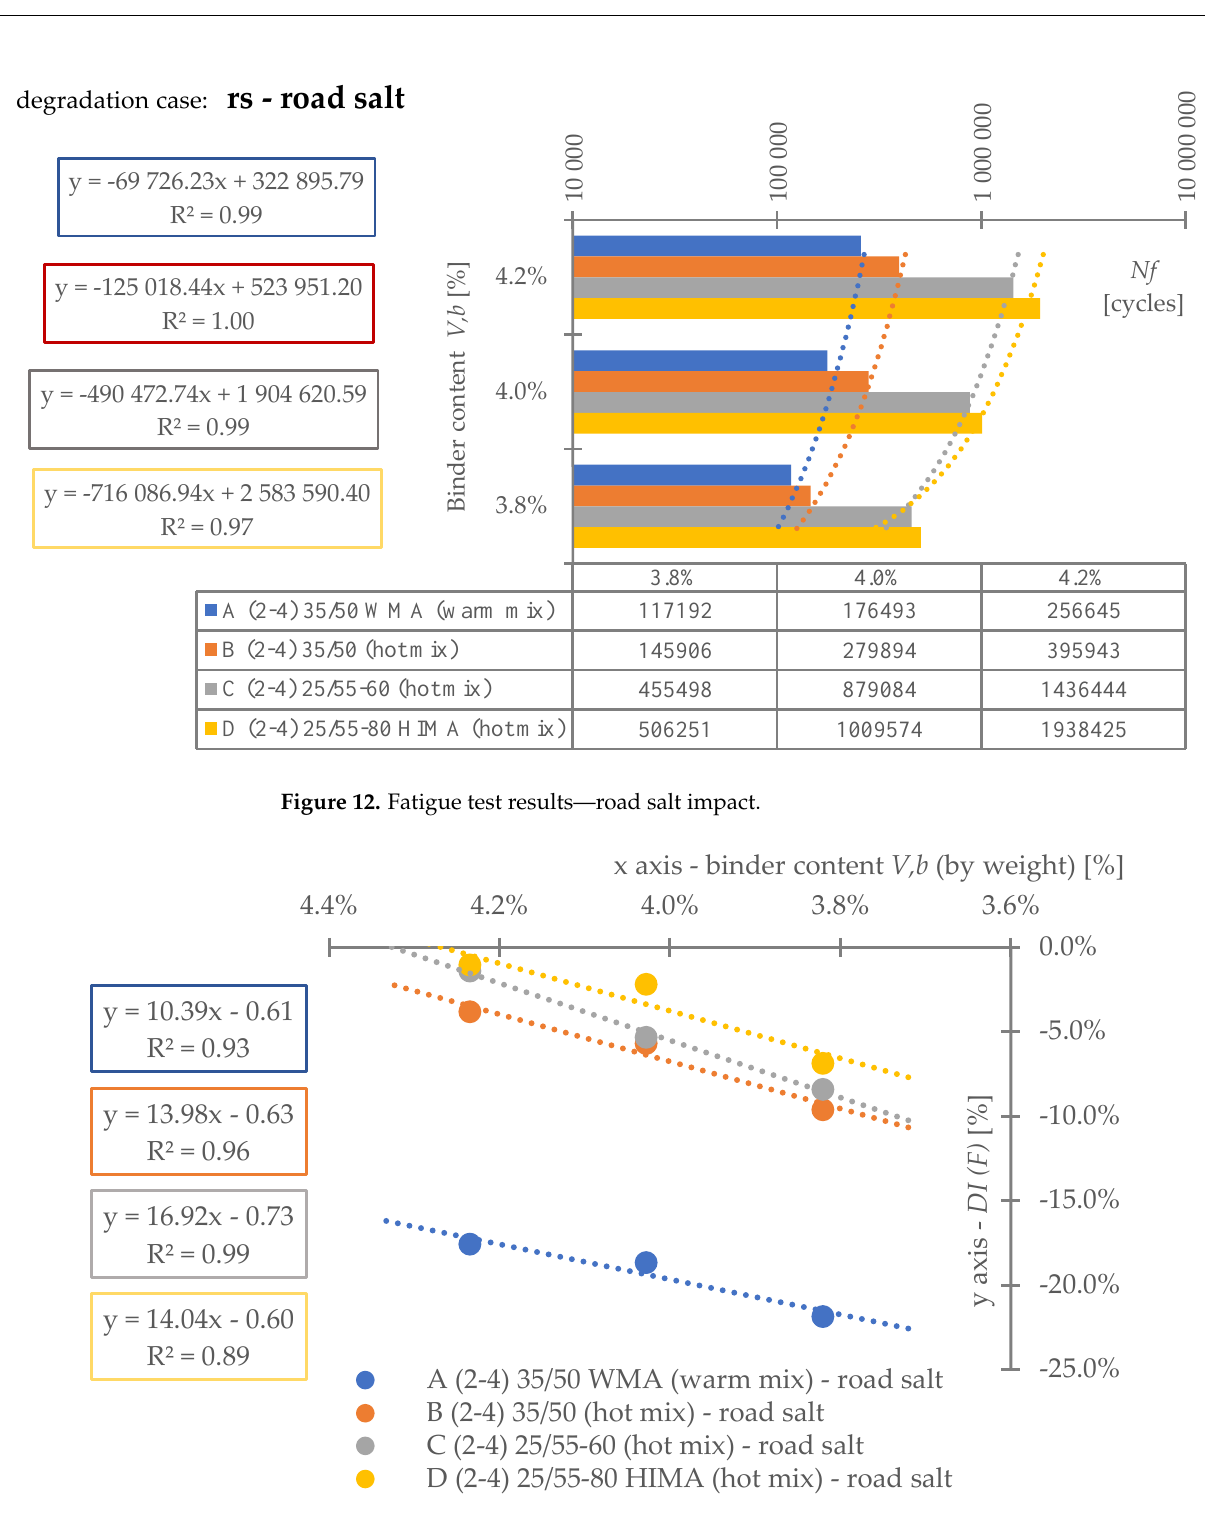
Figure 13. Degradation ratio variability (fatigue) through all mixes (road salt).